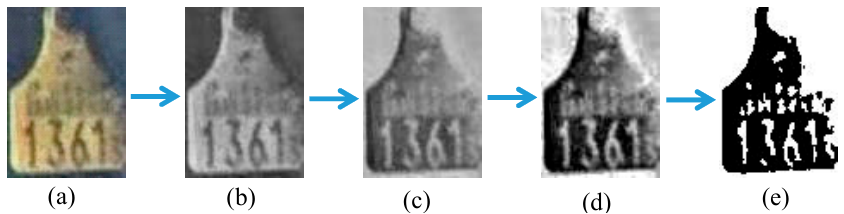
Figure 8. Illustration of skew image correction. 3.4. Ear Tag Recognition Process The goal of ear tag recognition is to identify the digits printed on the ear tag and then establish the position of the individual cow. 3.4.1. Preprocessing Ear tag images obtained from the filtering process must be segmented to get individual digits.